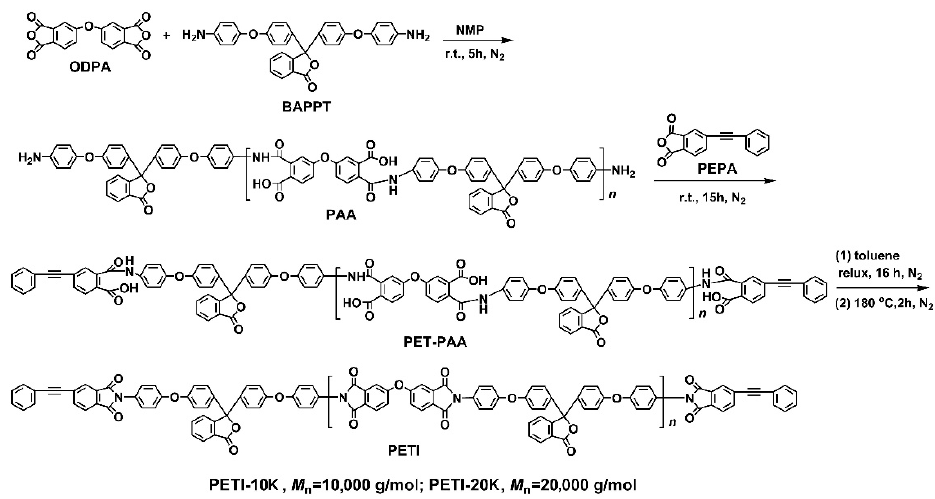
Figure 2. Synthesis of the phenylethynyl-terminated PI resins via a high-temperature polycondensation procedure. Table 1. Inherent viscosities, molecular weights, and solubility of PI